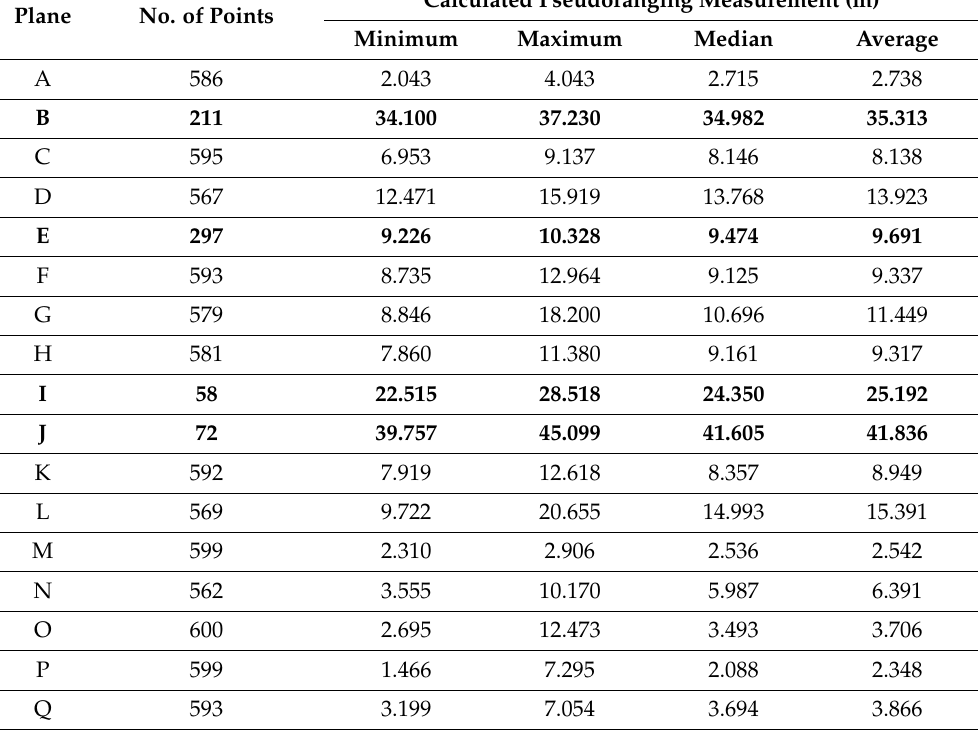
Table 7. The statistics of pseudoranging measurement in each plane after subsampling and blunder removal by the RANSAC algorithm for dataset